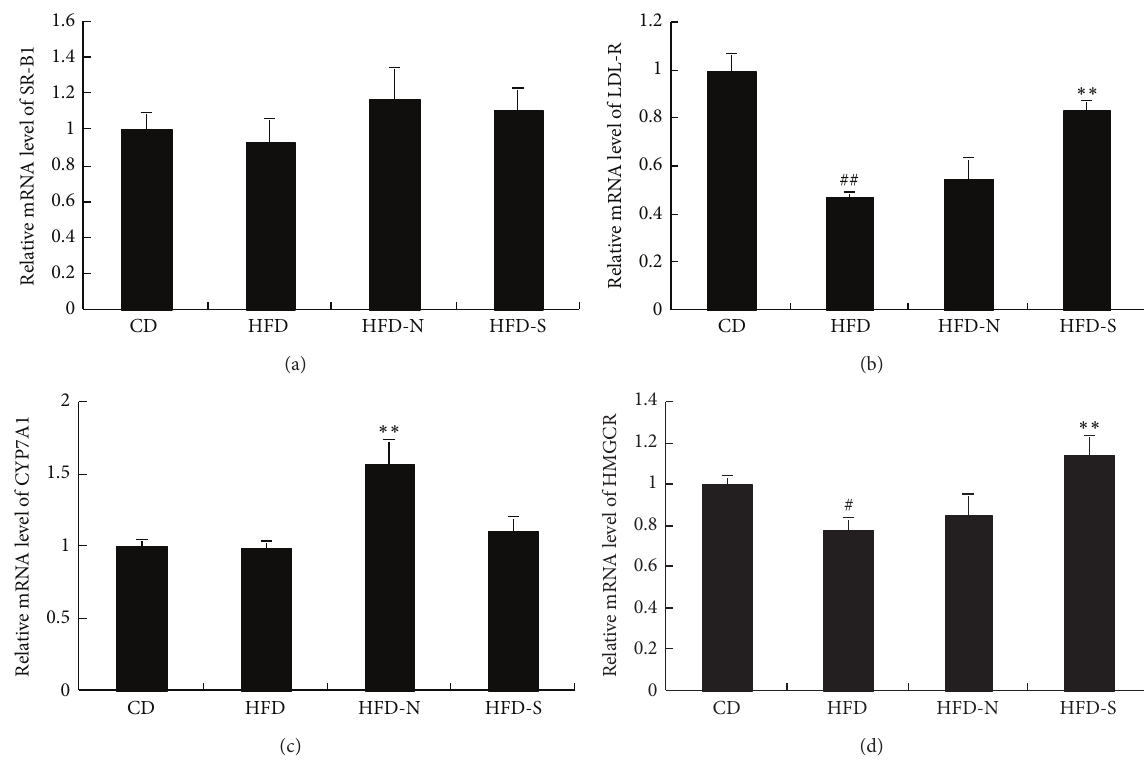
Figure 9: Effect of niacin and simvastatin on the mRNA abundance of SR-B1, LDL-R, CYP7A1, and HMGCR in liver of guinea pigs fed high fat diet. The mRNA levels, which were analyzed by quantitative real-time PCR, were calculated after being adjusted for 𝛽 -actin using the 2 −ΔΔ Ct method. Data are presented as mean ± SD of at least three independent experiments. # 𝑃 < 0.05 ; ## 𝑃 < 0.01 versus CD group; ∗∗ 𝑃 < 0.01 versus HFD